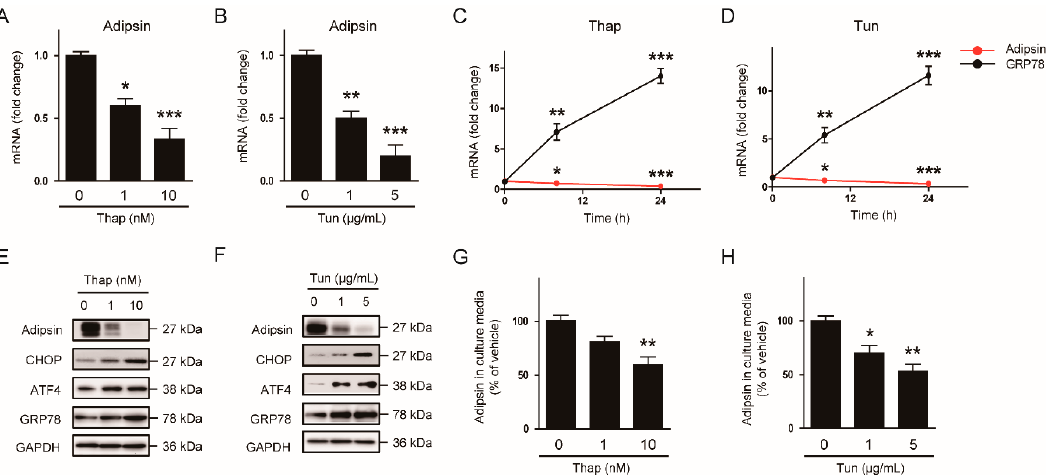
Figure 3. Chronic ER stress downregulates adipsin expression in vivo. C57BL/6N mice were fed a normal chow diet (ND) or a high-fat diet (HFD) for 12 weeks. ( A ) Real-time RT-PCR analysis of adipsin in gWATs. ( B ) Real-time RT-PCR analysis of CHOP, ATF4, and GRP78 in gWATs. ( C ) Western blot analysis of adipsin, CHOP, ATF4, GRP78, and GAPDH in gWATs. GAPDH was used as a loading control. Each lane represents an individual animal. ( D ) Serum levels of circulating adipsin. n = 8 per group. All data are represented as the mean ± SEM. * p < 0.05, ** p < 0.01, and *** p < 0.001 vs. ND-fed group.